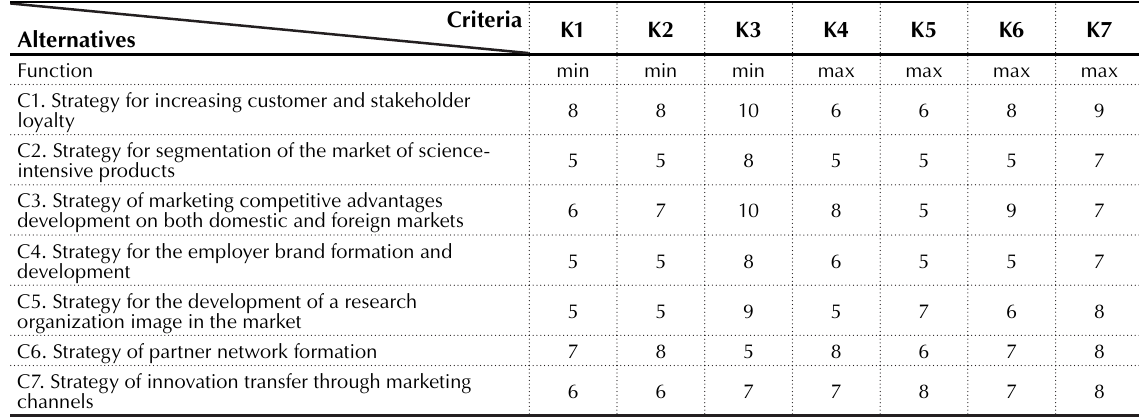
Table 11. Output data (decision matrix) on ranking the strategies for market capital development by the COPRAS method